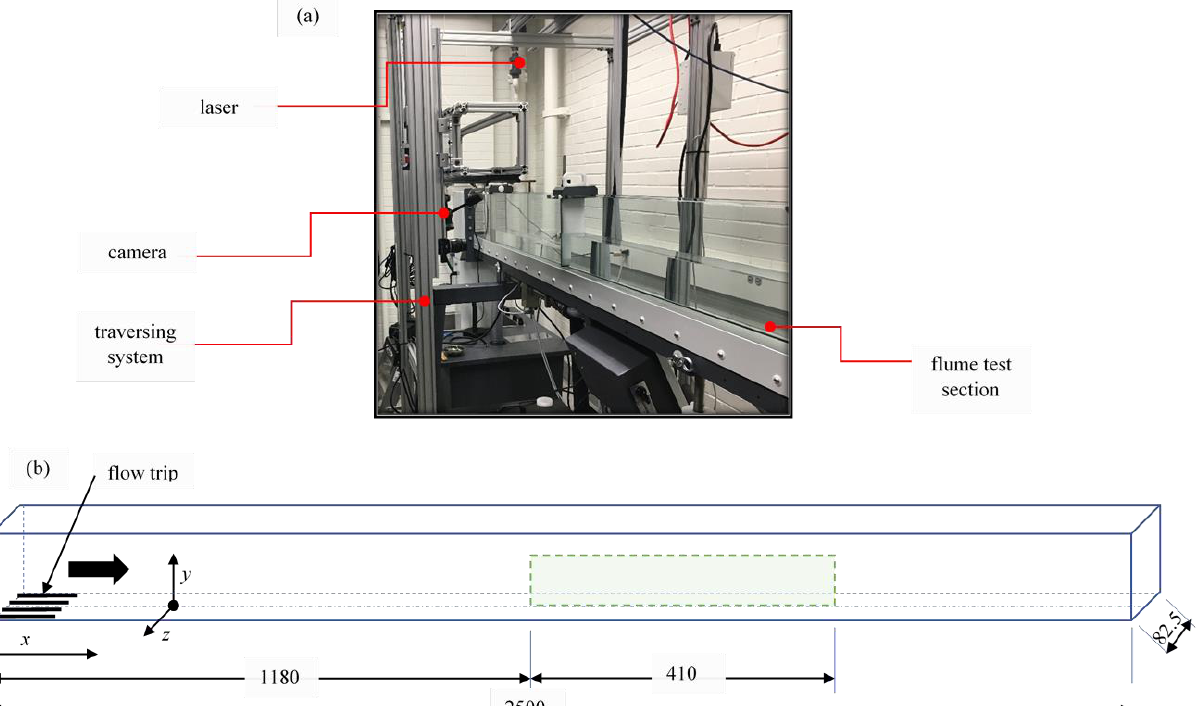
Figure 1. ( a ) Experimental set-up, and ( b ) schema of the test section and the coordinate system employed in this work. The green shaded section in ( b ) covers the focus of PIV measurement. All dimensions are in millimeters. The symbols x , y , and z represent the directions along the stream, wall-normal, and the span, respectively.